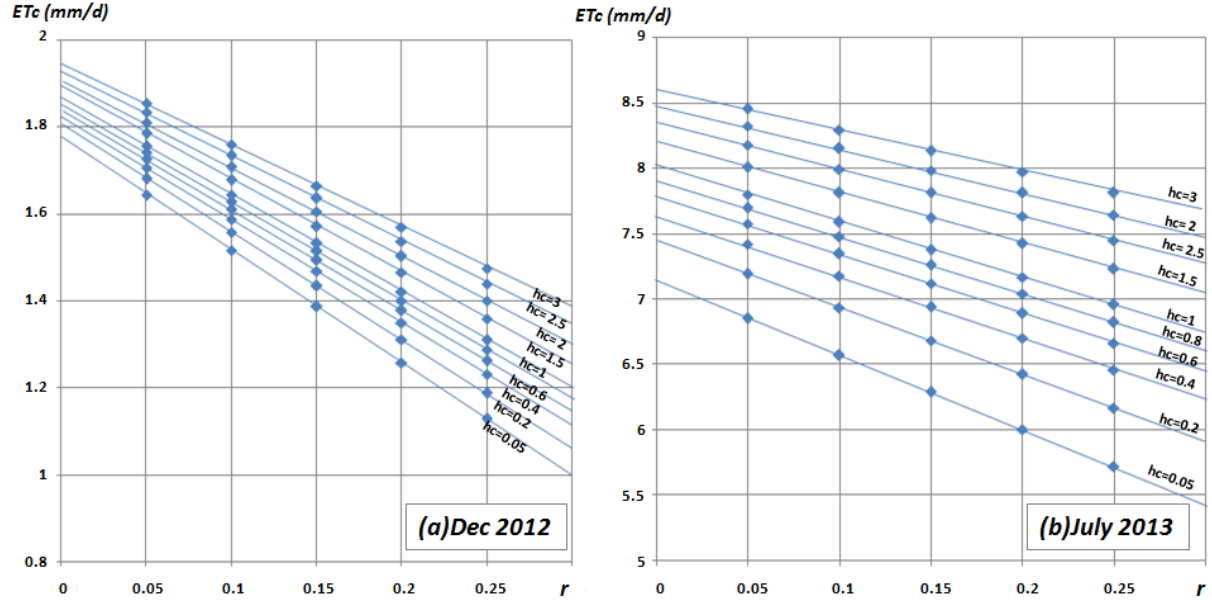
Figure 12. Relationship between crop evapotranspiration ET surface albedo r for different values of h June 2013 ( b